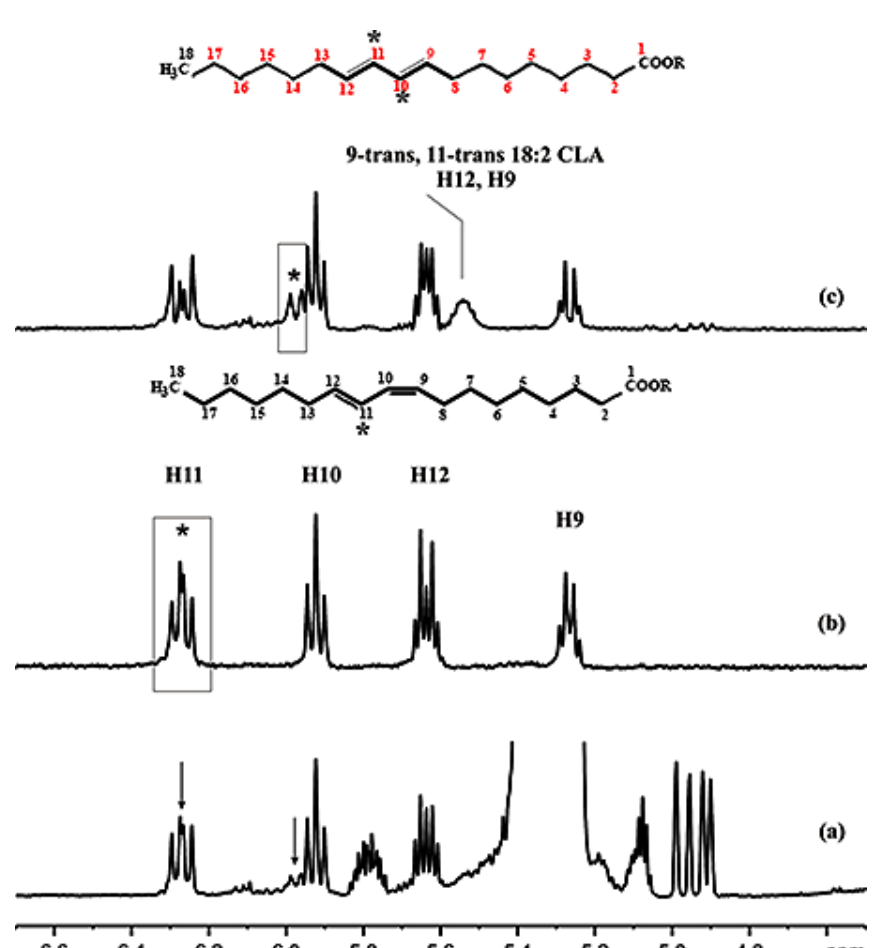
Figure 30. ( a ) Selected region of the 1D 1 H-NMR spectrum of the solution of Figure 28a. The asterisks denote the position of the selected target resonances which were excited. ( b , c ) selective 1D TOCSY spectra of the above solution. In ( b ) τ m = 400 ms was used for magnetization transfer from H11 to H9 of the (9- cis , 11- trans ) 18:2 CLA. In ( c ) τ m = 70 ms was used in order to optimize magnetization transfer from H10, 11 to H9, 12 of the (9- trans , 11- trans ) 18:2 CLA. The asterisks denote the resonances that were excited with the use of a selective pulse.